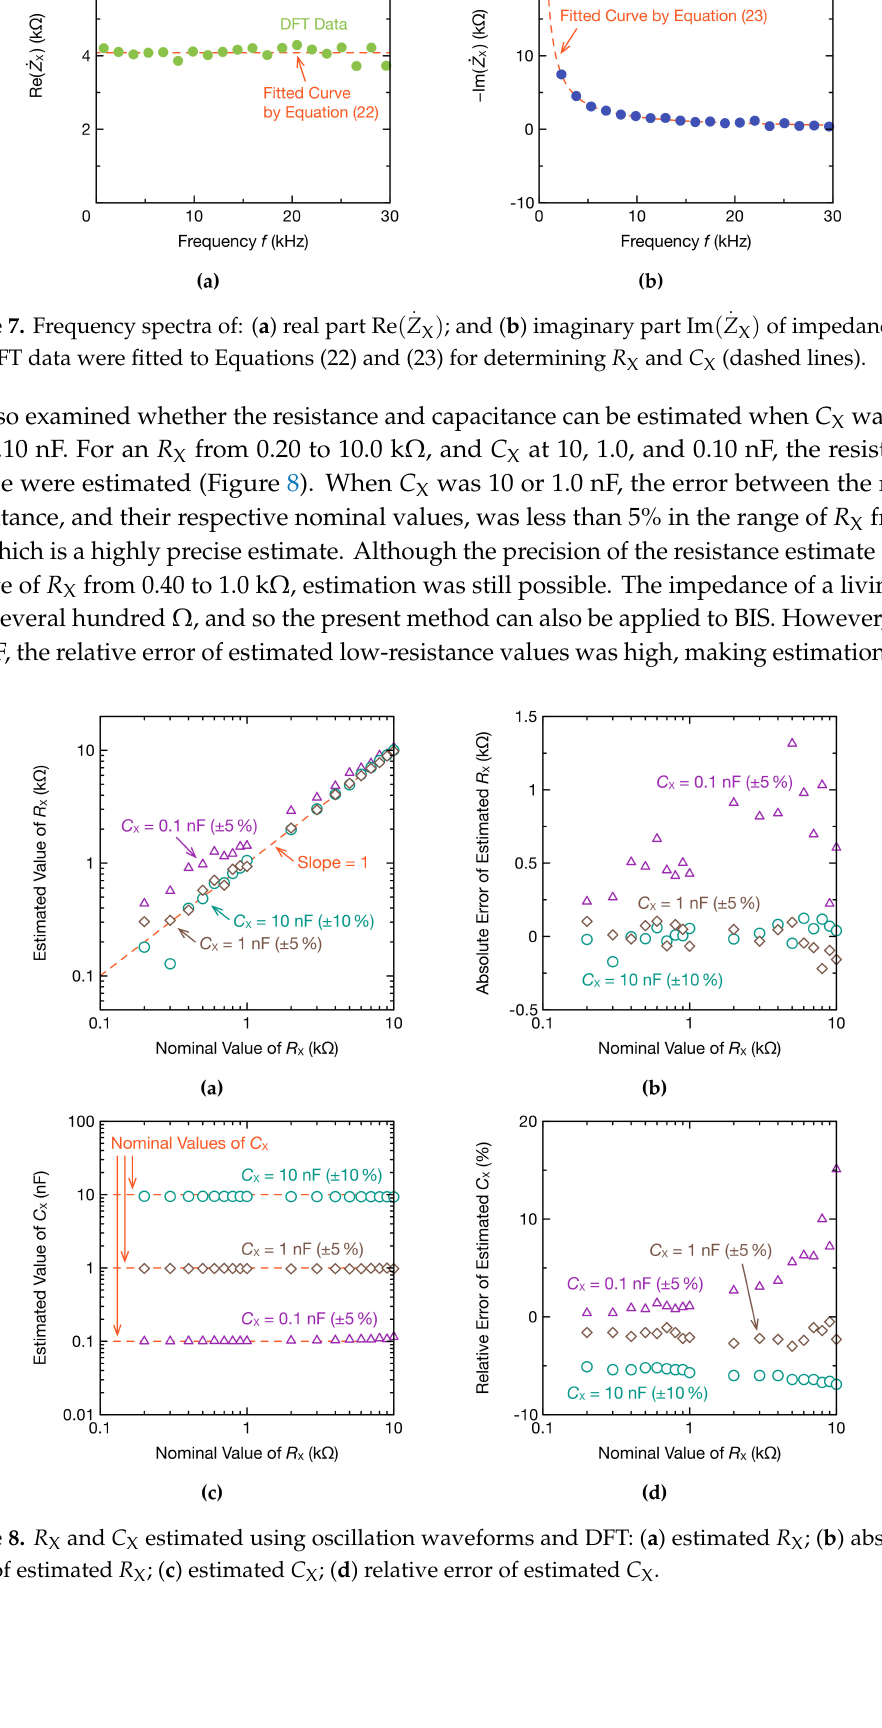
Figure 7. Frequency spectra of: ( a ) real part Re (